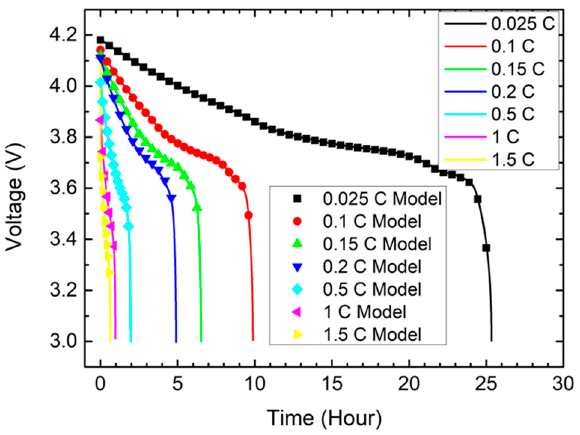
Figure 6. Curve of P brand 18650, Epoch = 100, look_back = 10.